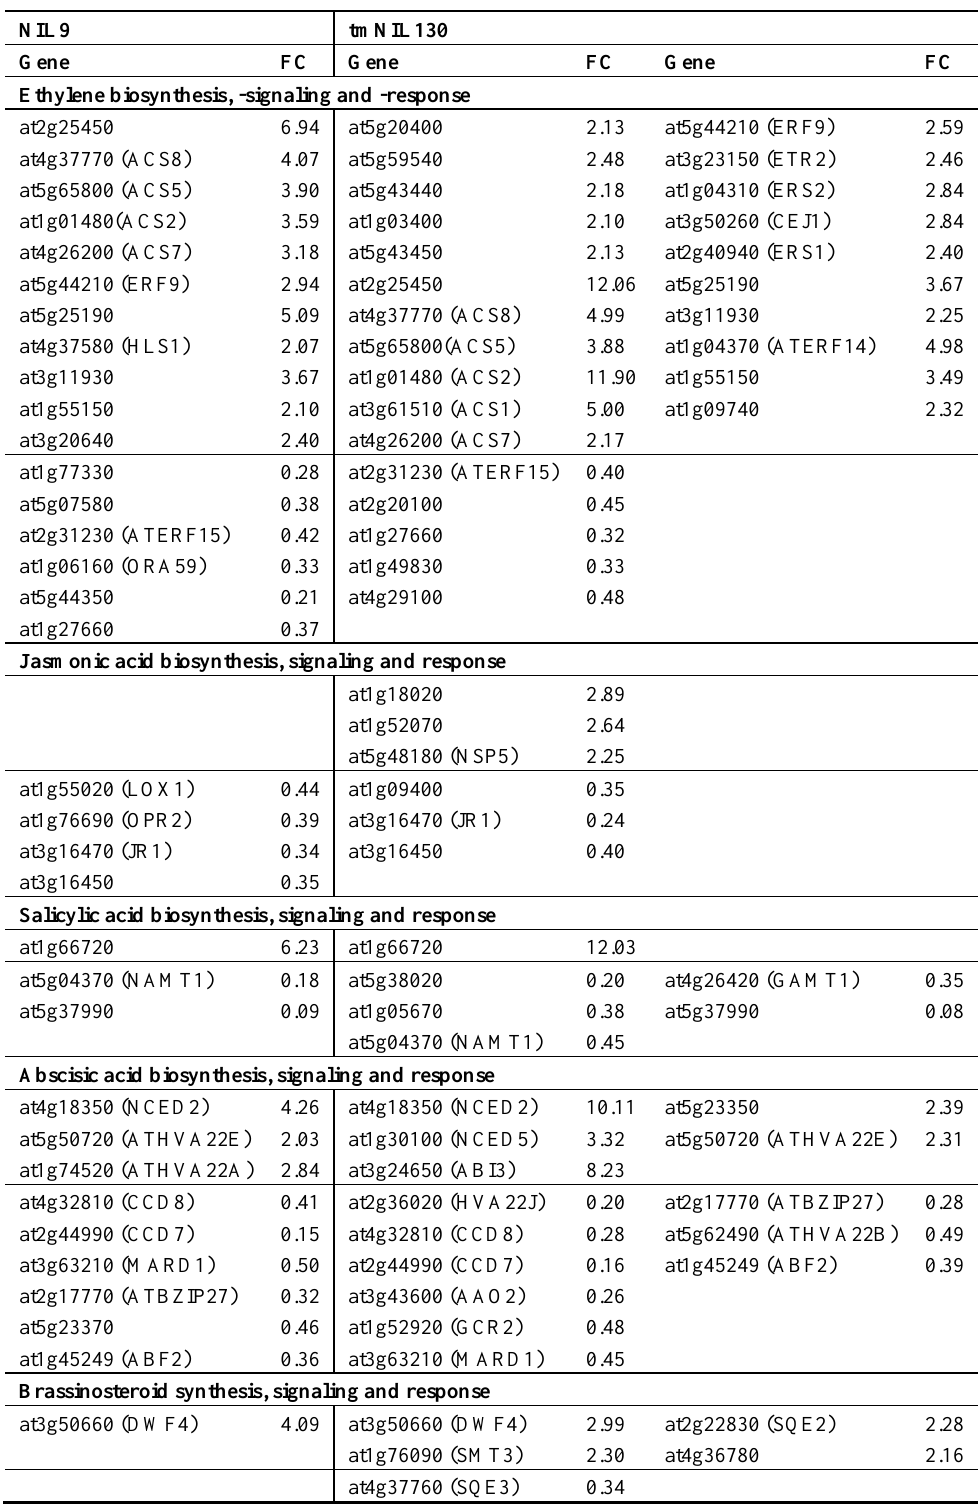
Table 1. Regulatory pathway genes differentially expressed by V. longisporum infection in the hypocotyl and basal shoot of two A. thaliana (Bur × L er ) near-isogenic lines (NILs) at the onset of silique maturity in a microarray experiment. NIL9 tmNIL130 Gene FC Gene FC Gene